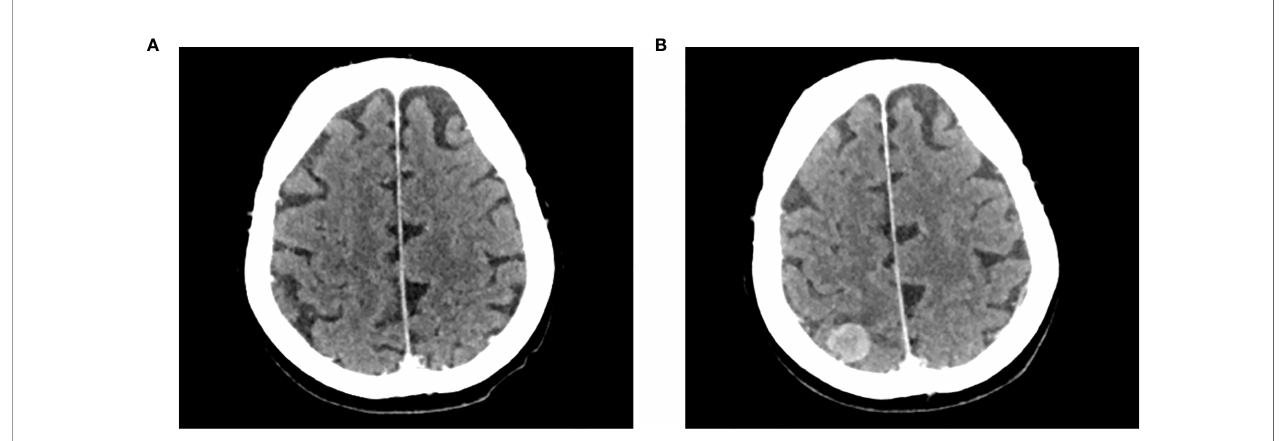
FIGURE 1 | Development of an asymptomatic brain metastasis in patient case 1. Computed tomography brain scans of patient case 1 prior to initiating treatment with avelumab (A) on August 16, 2017, and (B) on October 2,